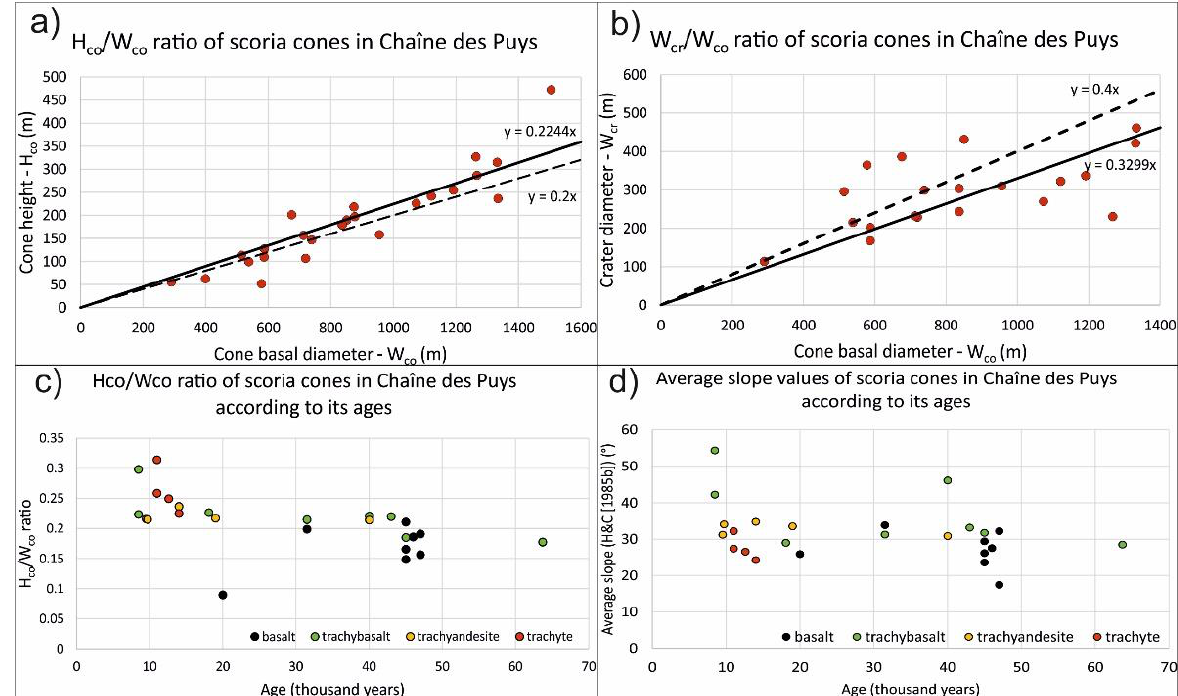
Figure 5. ( a ) H co / W co ratio, ( b ) W cr / W co ratio, ( c ) H co / W co ratio according to ages (black: basalt, green: trachybasalt, yellow: trachyandesite, red: trachyte), ( d ) average slope values according to ages (black: basalt, green: trachybasalt, yellow: trachyandesite, red: trachyte).